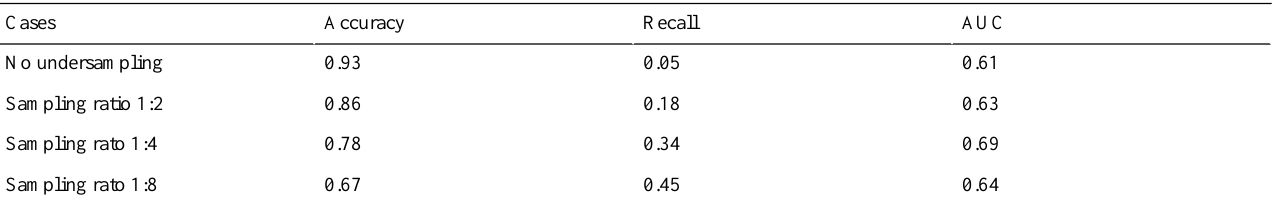
Table 2. Accuracy, recall, and area under the receiver operating characteristic curve (AUC) of each neural network model, with a cutoff of >0.5 for the dichotomous